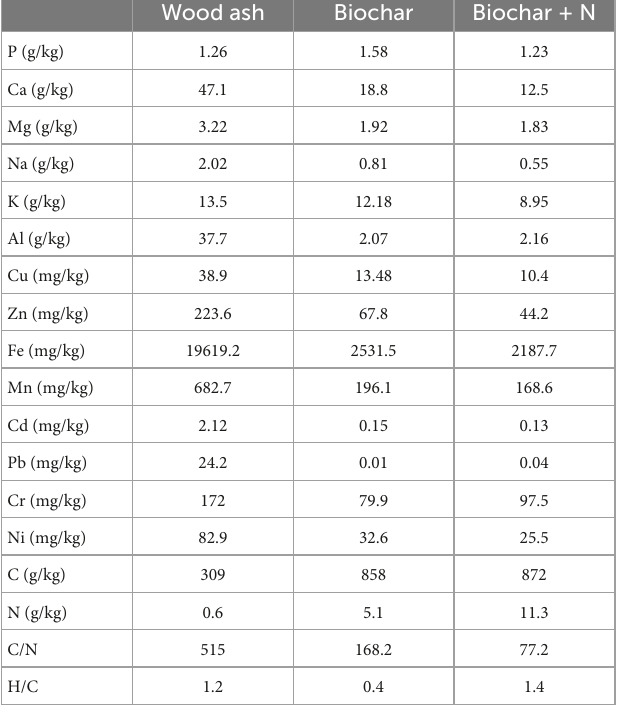
TABLE 1 Chemical characterization of the biochar and wood ash applied in the field trial. Wood ash Biochar Biochar + N